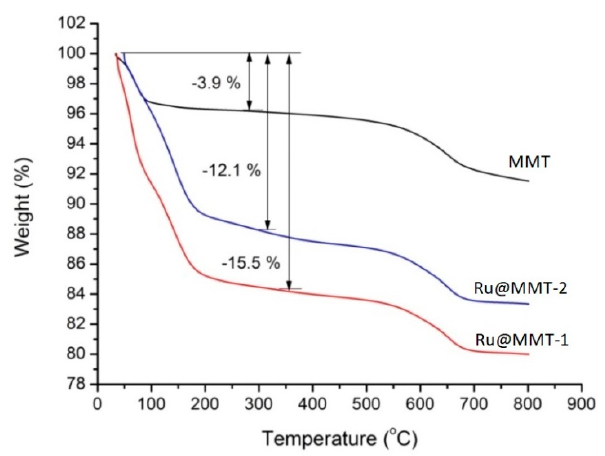
Figure 7. The thermogravimetric (TG) curve of MMT, Ru@MMT-1 and Ru@MMT-2 described their weight loss percentage upon temperature gradient.